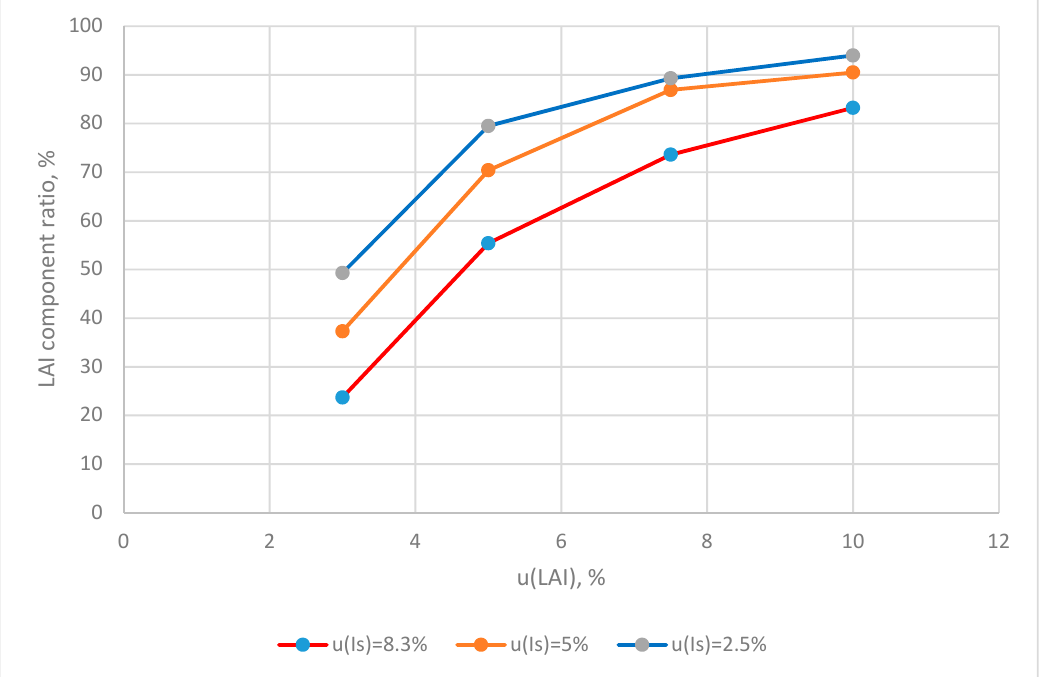
Figure 3. The effect of u(LAI) and u(Is) on the LAI contribution ratio for the Baille equation.